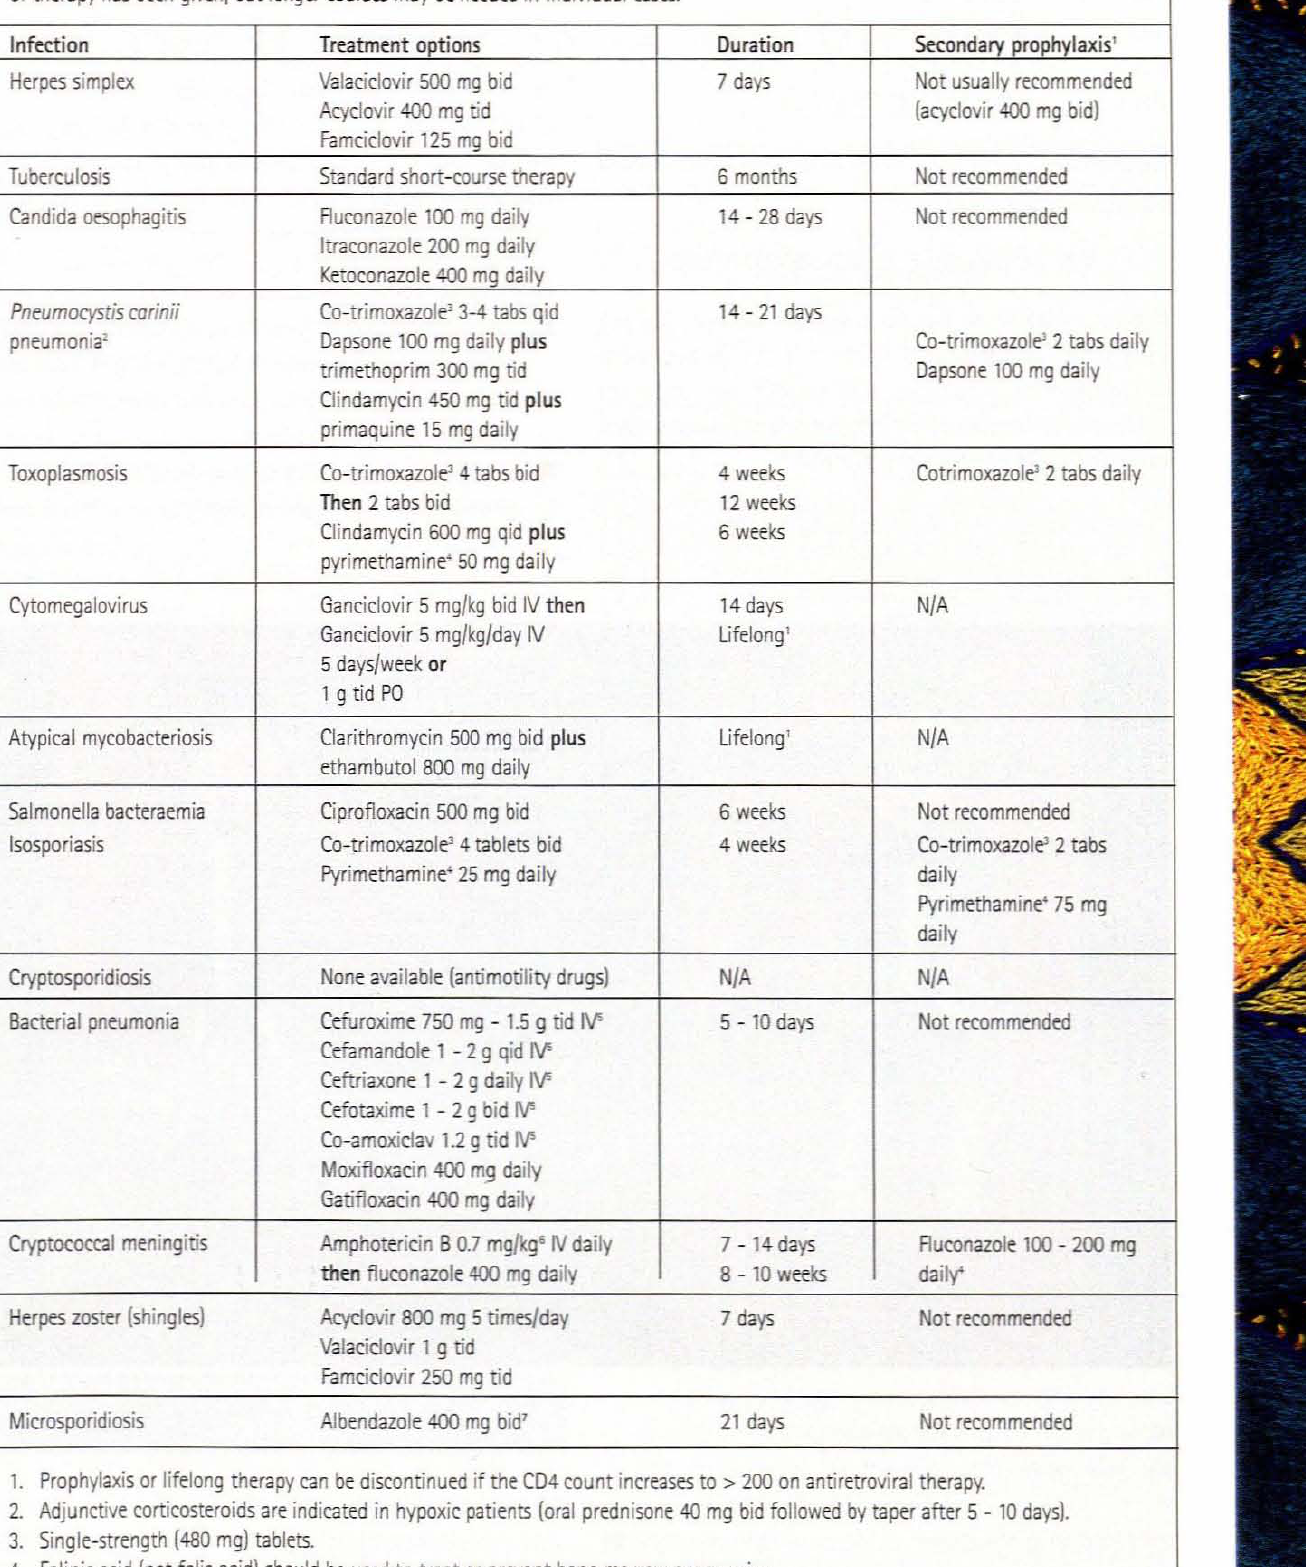
TABLE I. TREATMENT AND SECONDARY PROPHYlAXlS OF OPPORTUNISTIC INFEcnONS IN ADULTS Standard adult doses have been given. Every effort has been made to check doses. but readers should check other sources. Usual duration of therapy has been given, but longer courses may be needed in individual